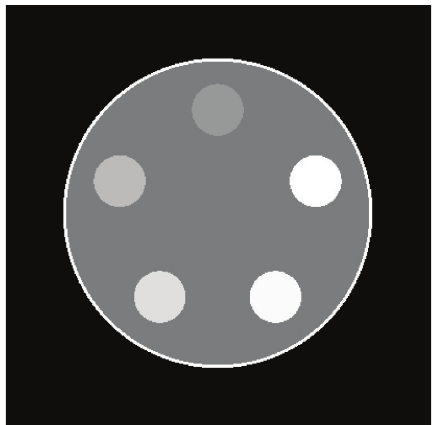
Figure 2: Normalized scaled densities of the modeled 30 cm diameter water phantom containing small cylinders of various concentrations of iodine with windowing of 𝐶 = 0 and 𝑊 = 100